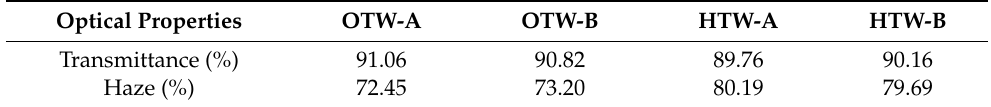
Table 1. Average transmittance and haze of OTW and HTW A and B